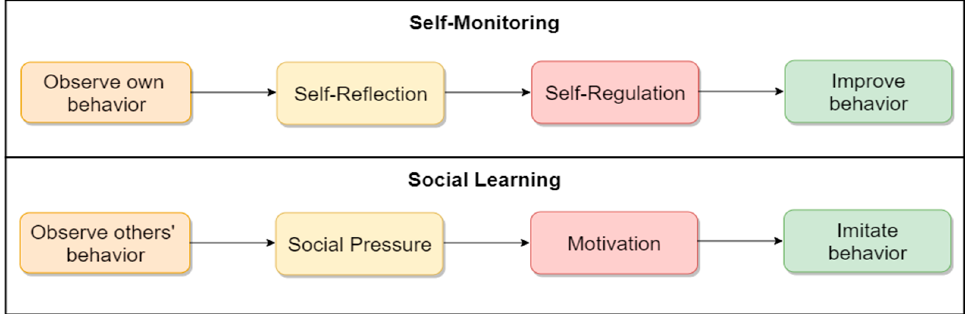
Figure 3. The operational mechanism of self-monitoring and social learning [14].